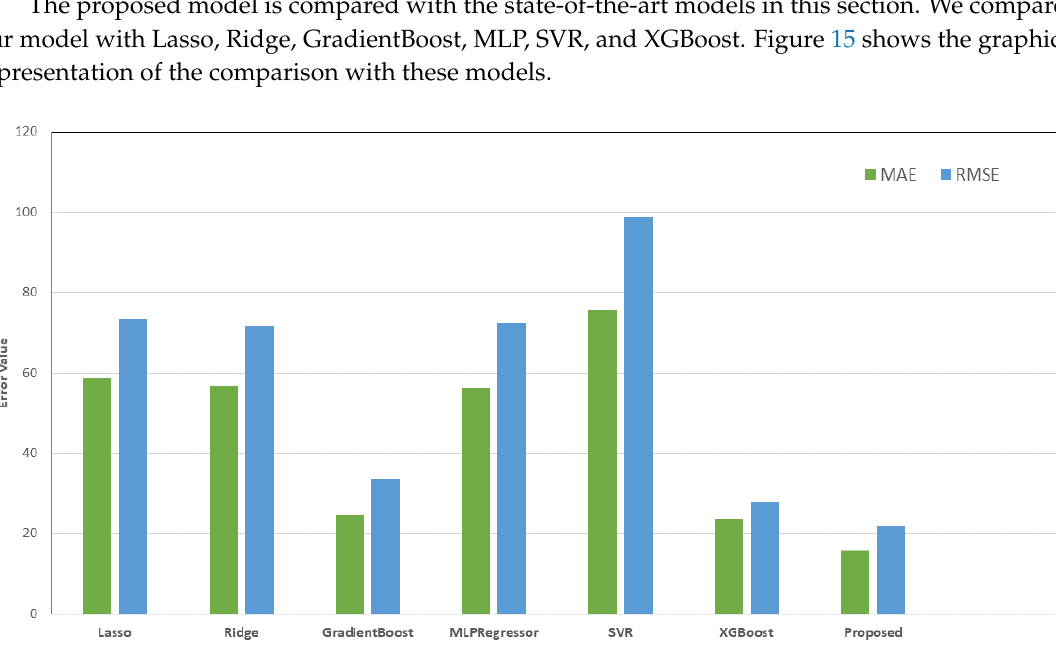
Figure 15. Comparison of MAE and RMSE with different